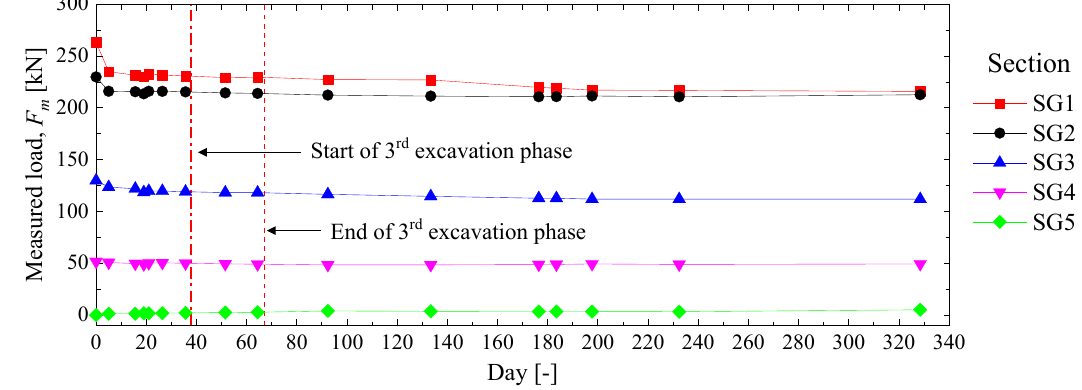
Figure 20 - Load monitoring along time for anchor